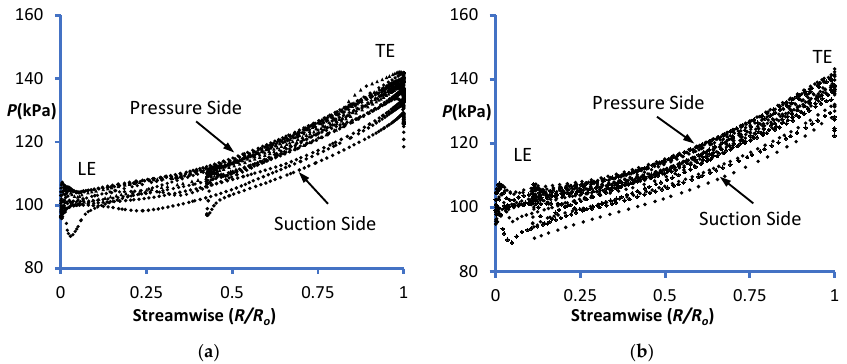
Figure 21. Pressure distribution at the axial central plane: ( a ) Ref2 design and ( b ) Opt2a design .